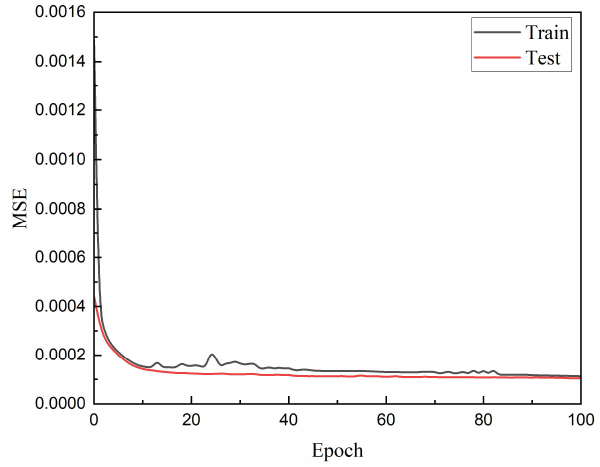
Figure 5. Training error and test error of level-1 of hierarchical optimization.